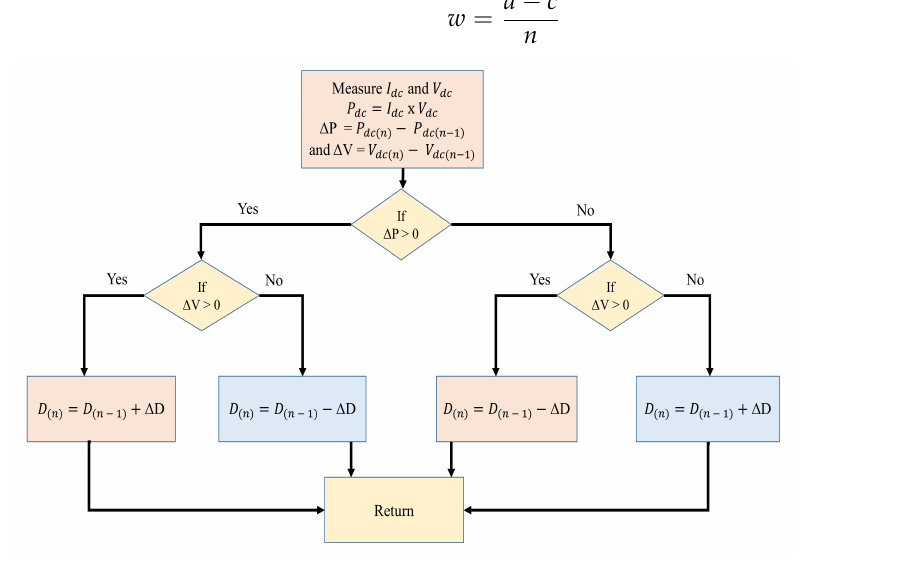
Figure 5. Procedure of the CPO method.